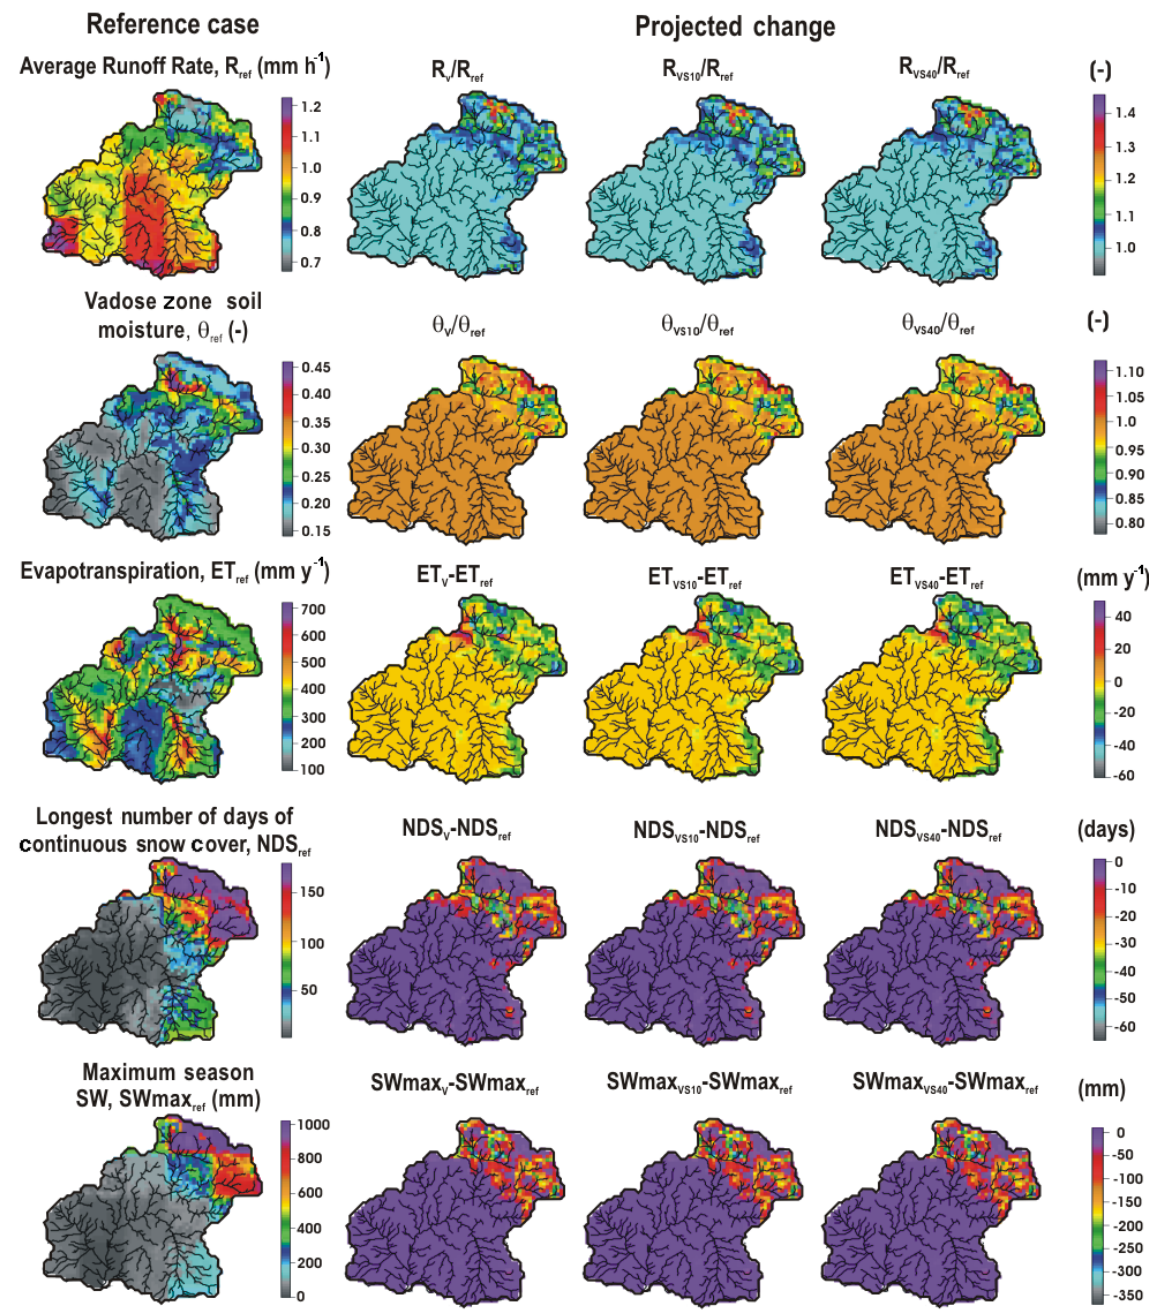
Figure 12. Simulated mean (first column) and projected changes (columns 2 through 4) in the mean multi-annual distribution of runoff ( R ref ), vadose zone soil moisture ( θ ref ), evapotranspiration (ET ref ), longest number of days with snow cover (NDS ref ) and maximum season snow water equivalent (SWmax ref ) due to forest thinning. Projected changes for the V, VS10 and VS40 cases are presented in terms of ratios or absolute differences, using the same color